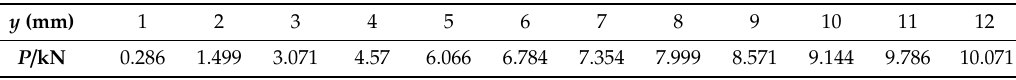
Figure 13. The loading system and the loading process setup. ( a ) Schematic of the loading system; ( b ) Photographs of the loading process and the model support. Table 11. The applied load P at each loading